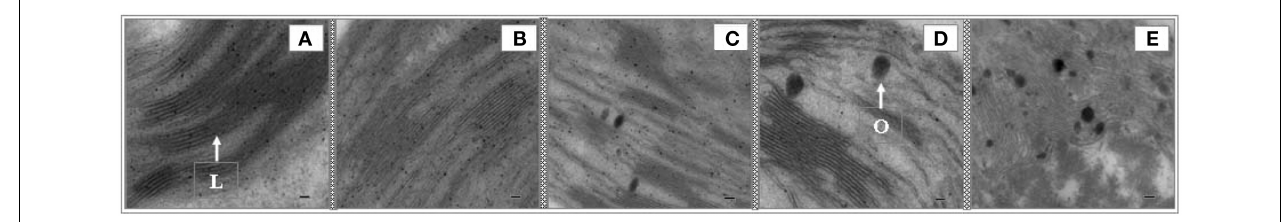
FIGURE 3 | Effects of salinity on the chloroplasts of T. Nitraria seedling leaves after treatment with 500mM NaCl. Images of the leaves were obtained using a transmission electron microscope (TEM-100CX II, Japan).